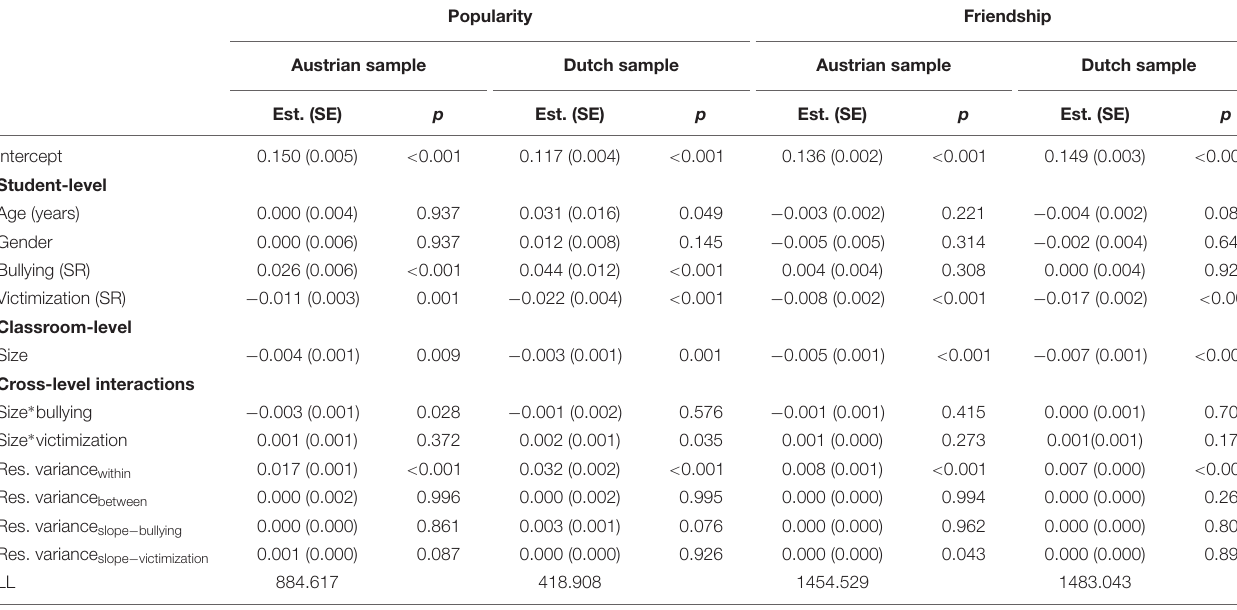
TABLE 4 | Main and interactive effects of age, gender, bullying, victimization, classroom size on popularity and friendship for the two samples.